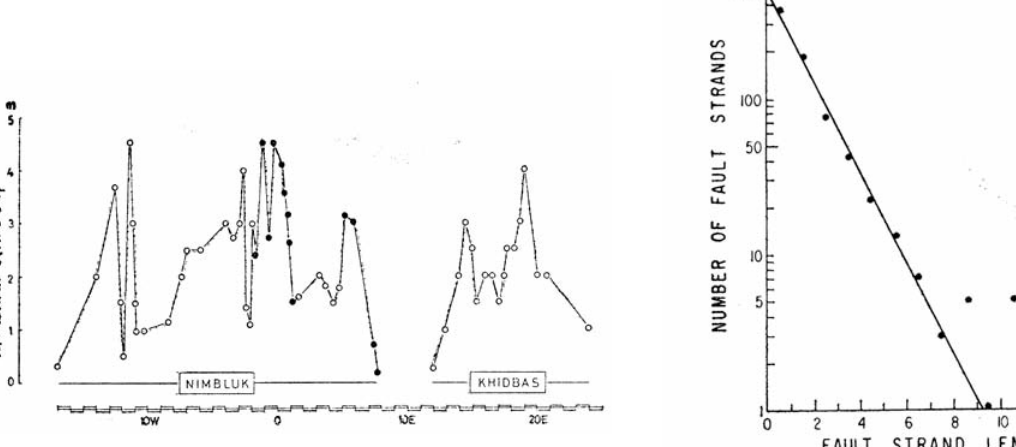
Figure 6. Horizontal displacement along the fault of Dasht-e Bayaz earthquake of 1968. Vertical axis is left-lateral displacement in meters. Horizontal axis is distance along the fault in kilometers. Solid circles indicate north-facing scarp and open circles south-facing scarp. Note the gap near 10 E. Reproduced from Tchalenko and Berberian [1975].